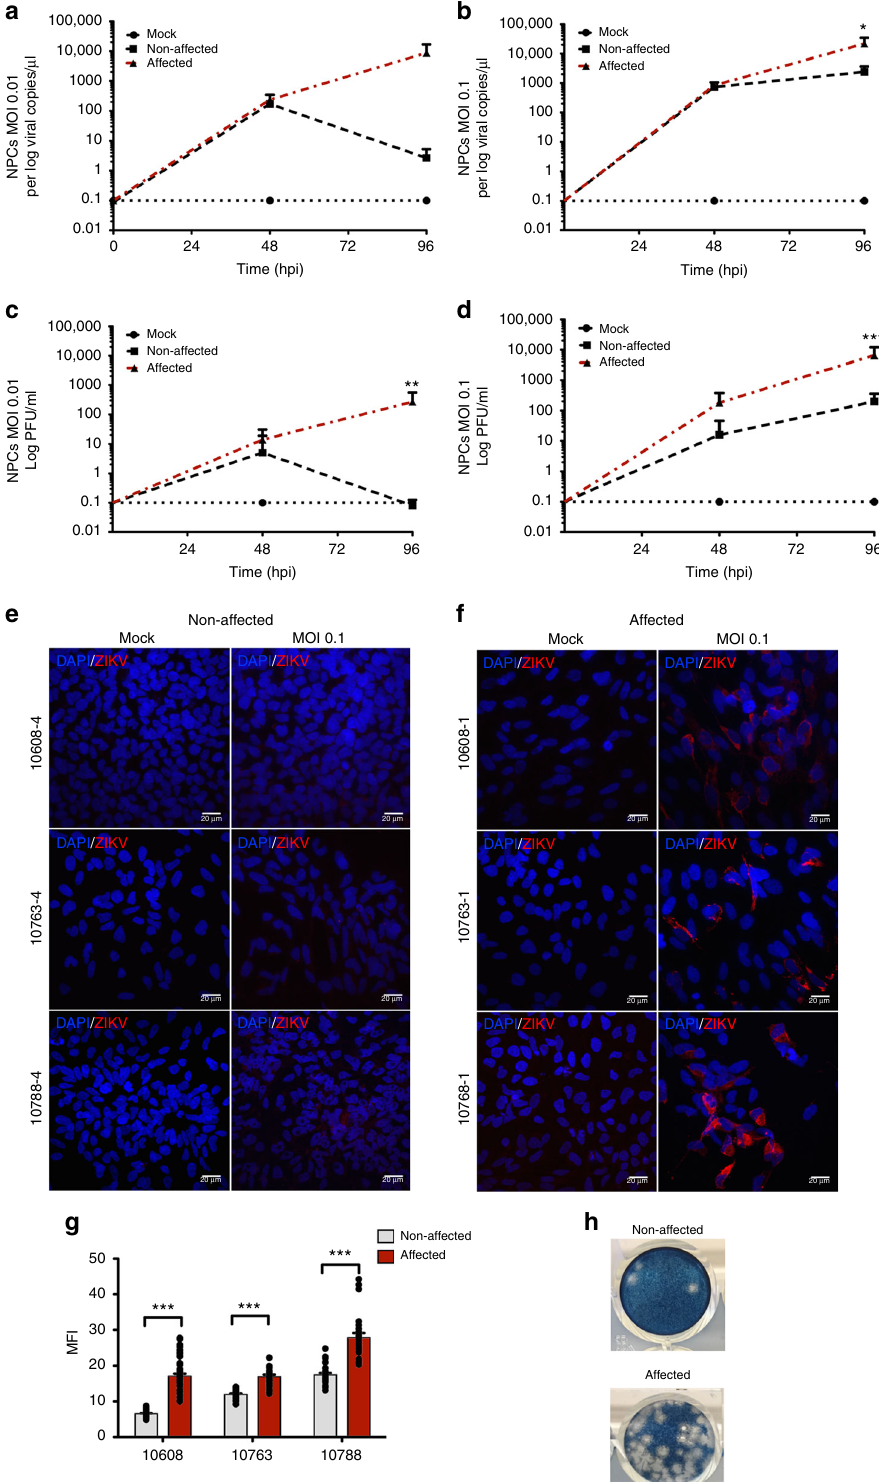
Fig. 3 NPCs from affected twins increased susceptibility to ZIKV BR infection compared to the non-affected ones (see also Supplementary Fig. 2). a , b Viral copies in supernatant of NPCs infected at an MOI = 0.01 ( a ) or MOI 0.1 ( b ) as determined by RT-qPCR. Graphs show mean ± SEM of NPCs from #10608, #10763, and #10788 twins. * p < 0.05, ** p < 0.01, and *** p < 0.001 one-way ANOVA with Tukey ’ s post hoc analysis. c , d Zika PFU/mL in NPCs supernatant ( c ) MOI = 0.01 and ( d ) MOI = 0.1; #10608, #10763, and #10788 twins; mean ± SEM; ** p < 0.01, *** p < 0.001; one-way ANOVA with Tukey ’ s post hoc analysis. e , f Zika staining in non-affected ( e ) and affected ( f ) twins at an MOI of 0.1 at 96 hpi; #10608, #10763, and #10788 twins. Scale bar = 20 µ m. g MFI quanti fi cation at 96 hpi (MOI = 0.1; n ≅ 20 technical replicates per group; mean ± SEM; *** p < 0.001; Student ’ s t test). h Representation of a well stained with ZIKV collected from #10608 NPC supernatant at an MOI of 0.1 at 96